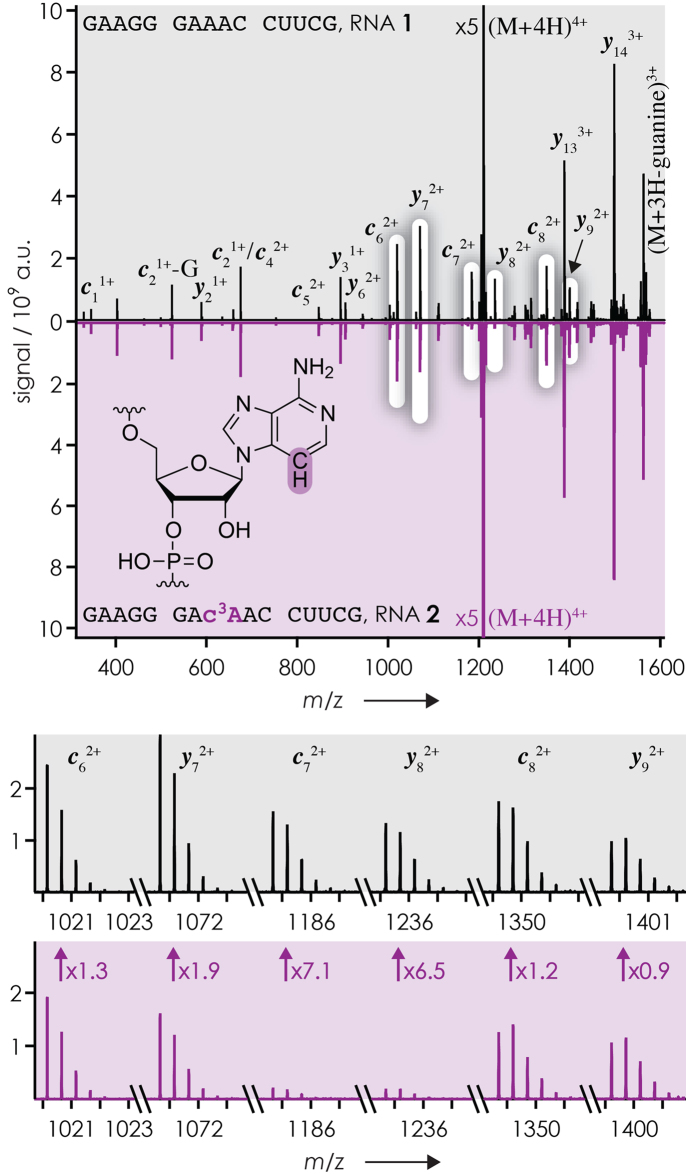
CAD spectra (42 eV laboratory frame collision energy) of (M+4H)4+ ions of RNA 1 (black) and 2 (purple, mirrored to facilitate comparison) electrosprayed from 1 μM solutions in 1:1 H2O/CH3OH with 20 mM ammonium acetate as additive (pH 6.8); signals of complementary c72+ and y82+ fragments from backbone cleavage between residues 7 and 8 (bottom; c62+, c82+, y72+, and y92+ shown for comparison) decreased by a factor of ∼7 as a result of replacing A with c3A at position 8; the difference in m/z of y82+, c82+, and y92+ from CAD of RNAs 1 and 2 reflects the mass difference between A and c3A of 0.9953 Da.